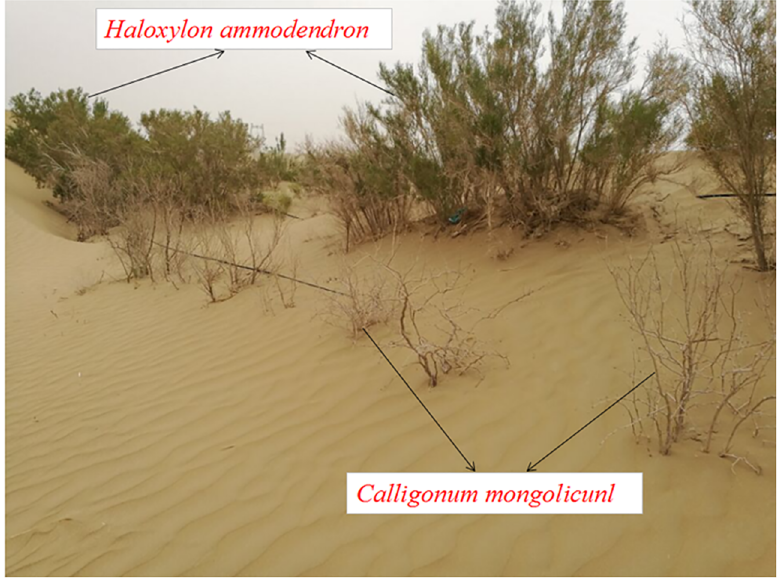
Fig 1. Growth status of Haloxylon ammodendron and Calligonum mongolicunl in parts of the Taklimakan DesertHighway Shelterbelt.